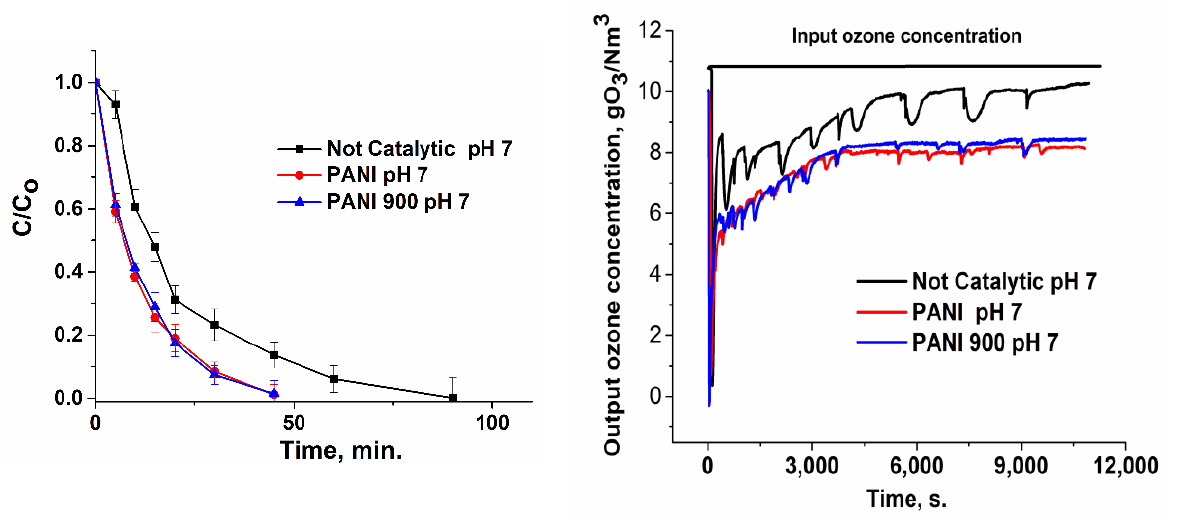
Figure 9. Variation in the normalized ibuprofen concentration and ozone concentration for the catalytic process at pH = 7.